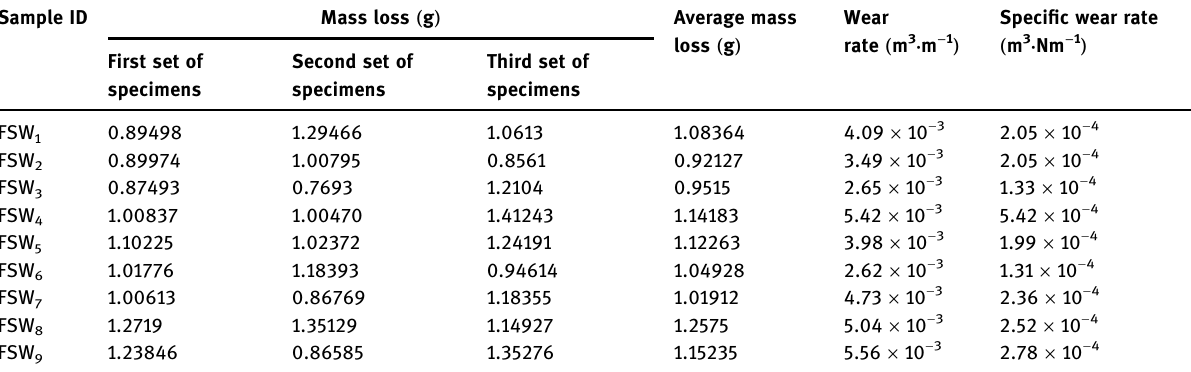
Table 2: Average mass loss, wear rate, and speci fi c wear rate of specimens Sample ID